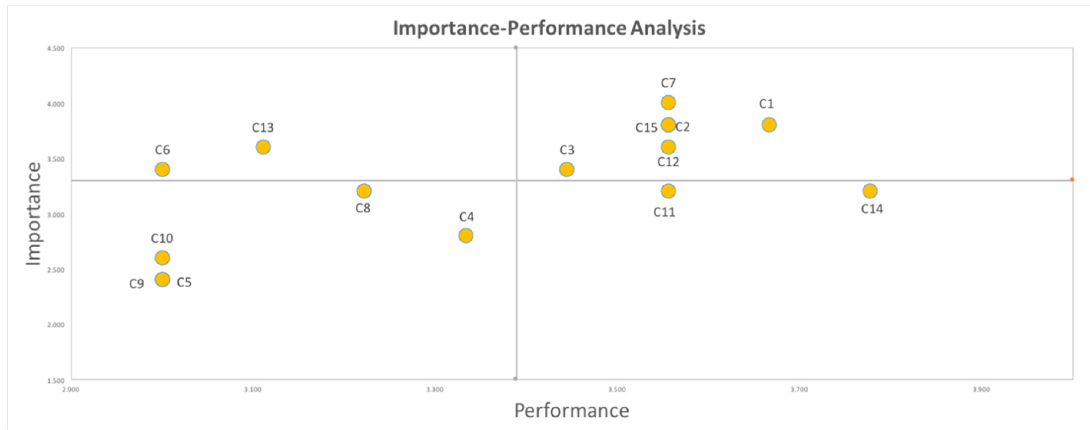
Figure 1. IPA chart based on data gathered in Finland, 2019 (created by authors). where C1—Spotting